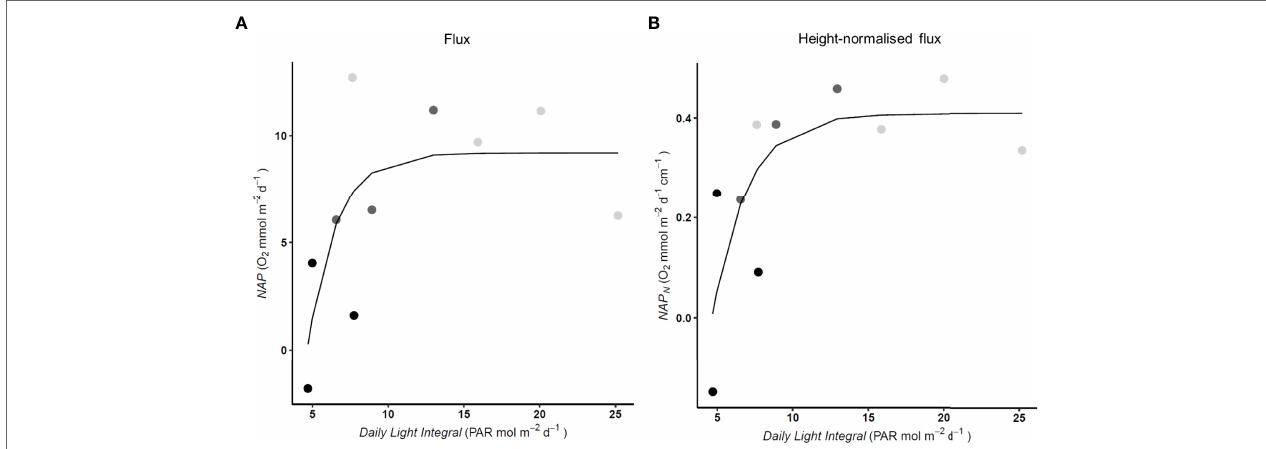
FIGURE 5 | (A) Net Apparent Productivity (NAP) (R 2 = 0.713) and (B) NAP canopy-height-normalised flux (NAP N ) (R 2 = 0.711) presented as a function of PAR given as the Daily Light Integral, for P. oceanica meadow edge determined across seasons with large benthic chambers. The irradiance compensation point ( I C ) was 4.6 mol photons m –2 d –1 . Replicate season denoted for visual reference autumn ( ● ), spring ( ● ) and summer ( ●